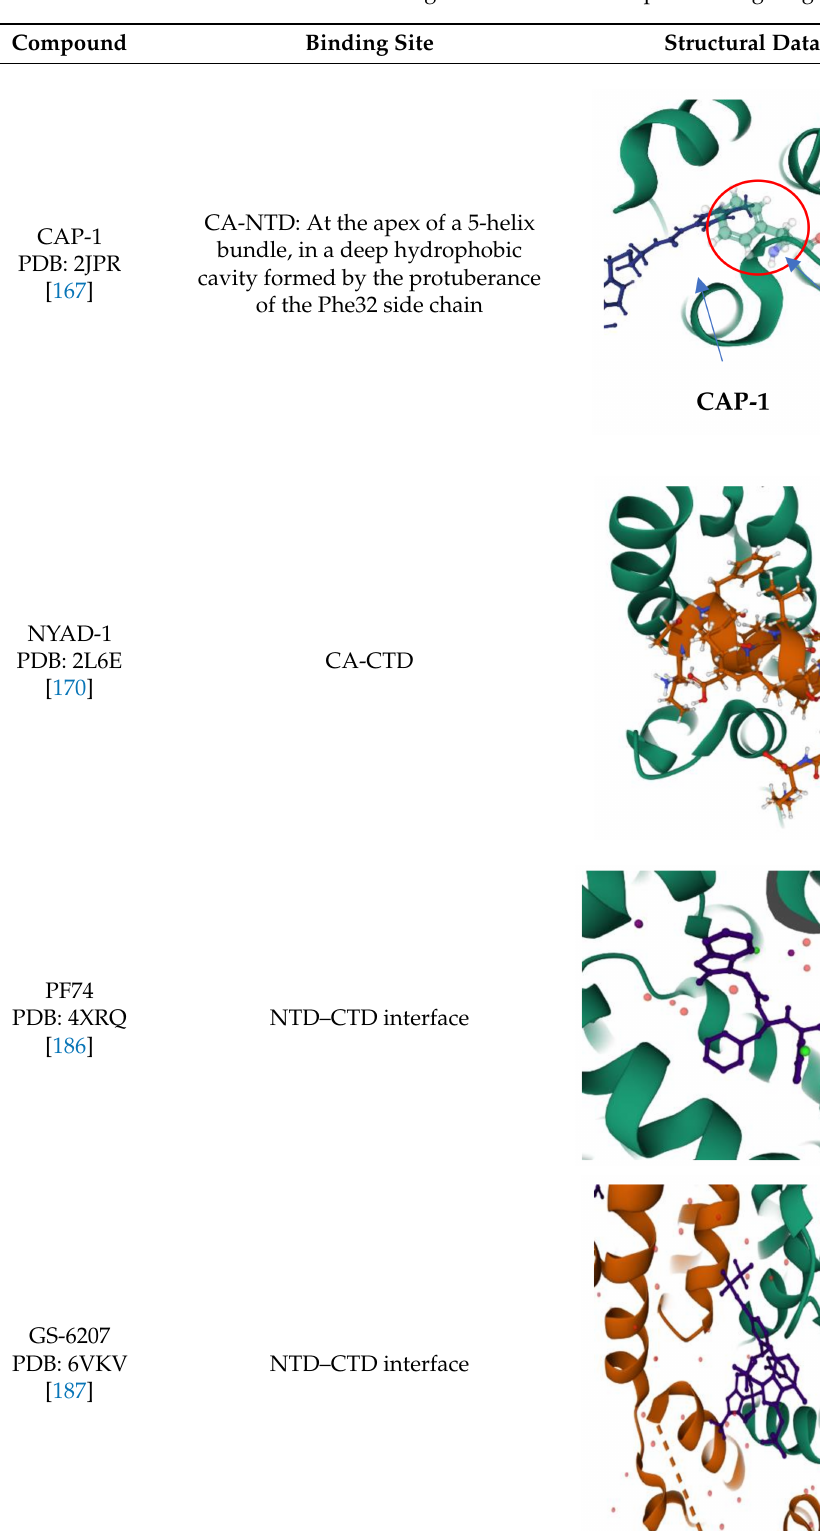
Table 1. Binding sites of selected compounds targeting HIV-1